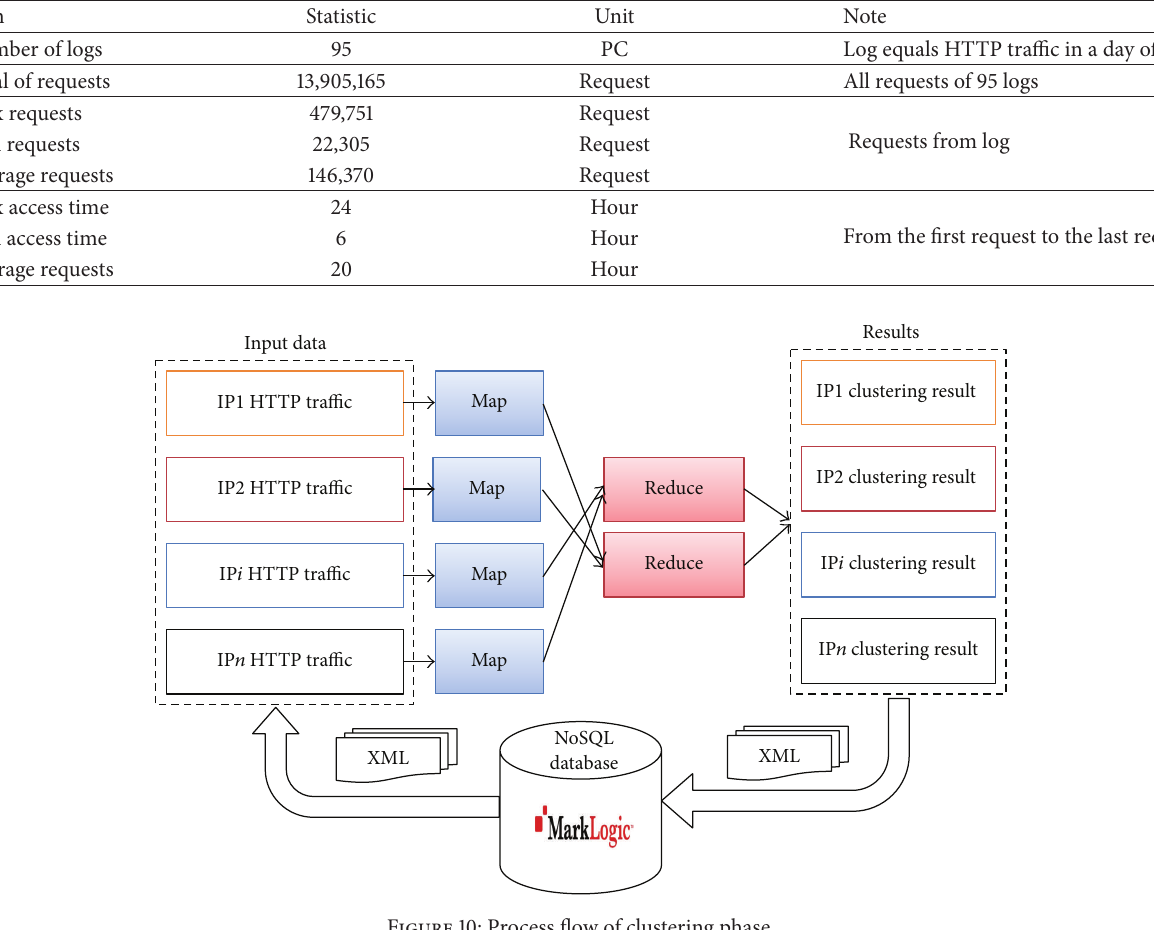
Table 1: Experimental data statistic.